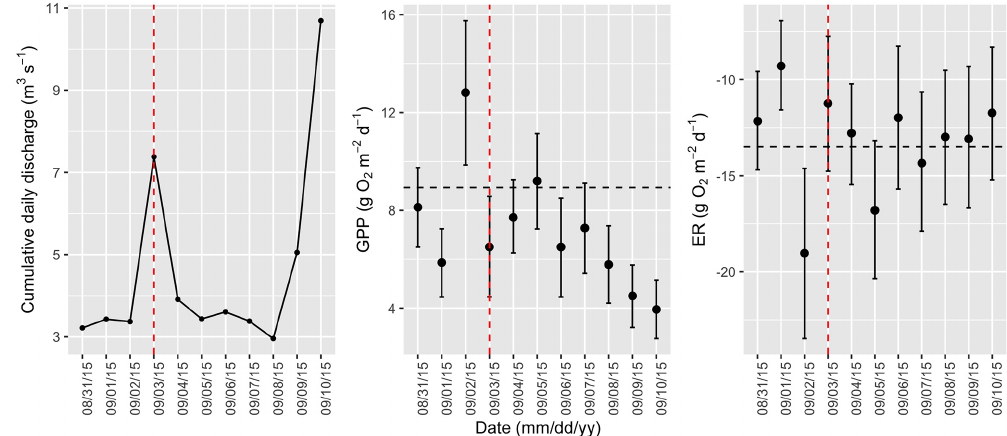
Figure A10. Cumulative daily discharge and metabolism (gross primary production and ecosystem respiration; GPP and ER) time series for the Stroubles Creek flow event on 3 September 2015 (noted with a dashed vertical red line in all three panels). The dashed horizontal black lines are mean values of GPP and ER prior to the high flow event. Error bars for posterior estimates of GPP and ER are 2.5% and 97.5% Bayesian credible intervals.